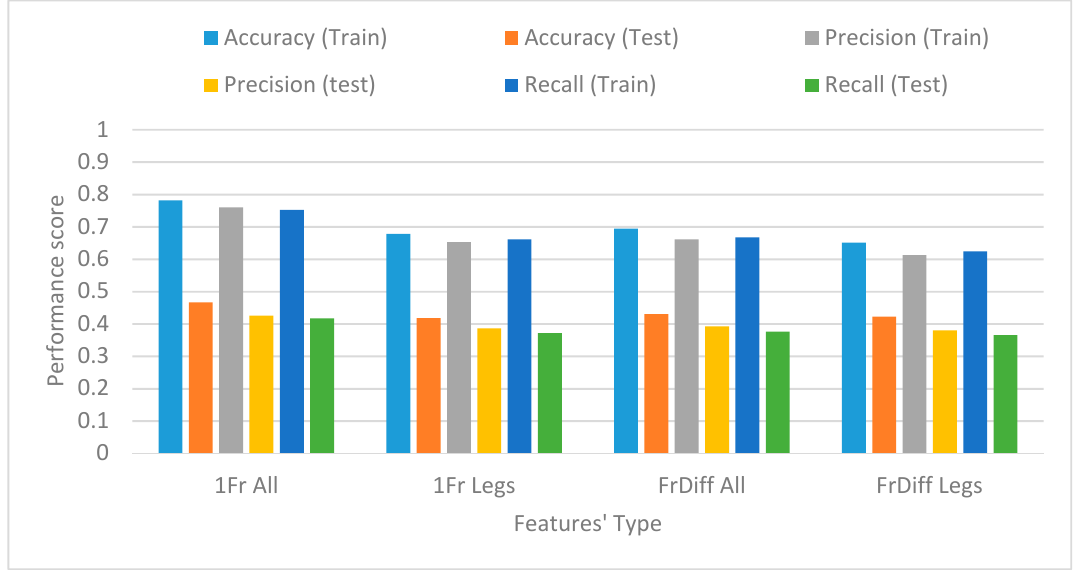
Figure 6. Impact of the feature creation related assumptions on the performance.